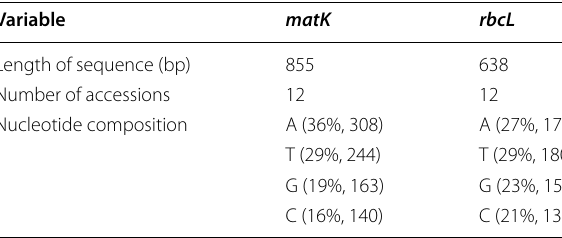
Table 5 Nucleotide variation in matK and rbcL chloroplast